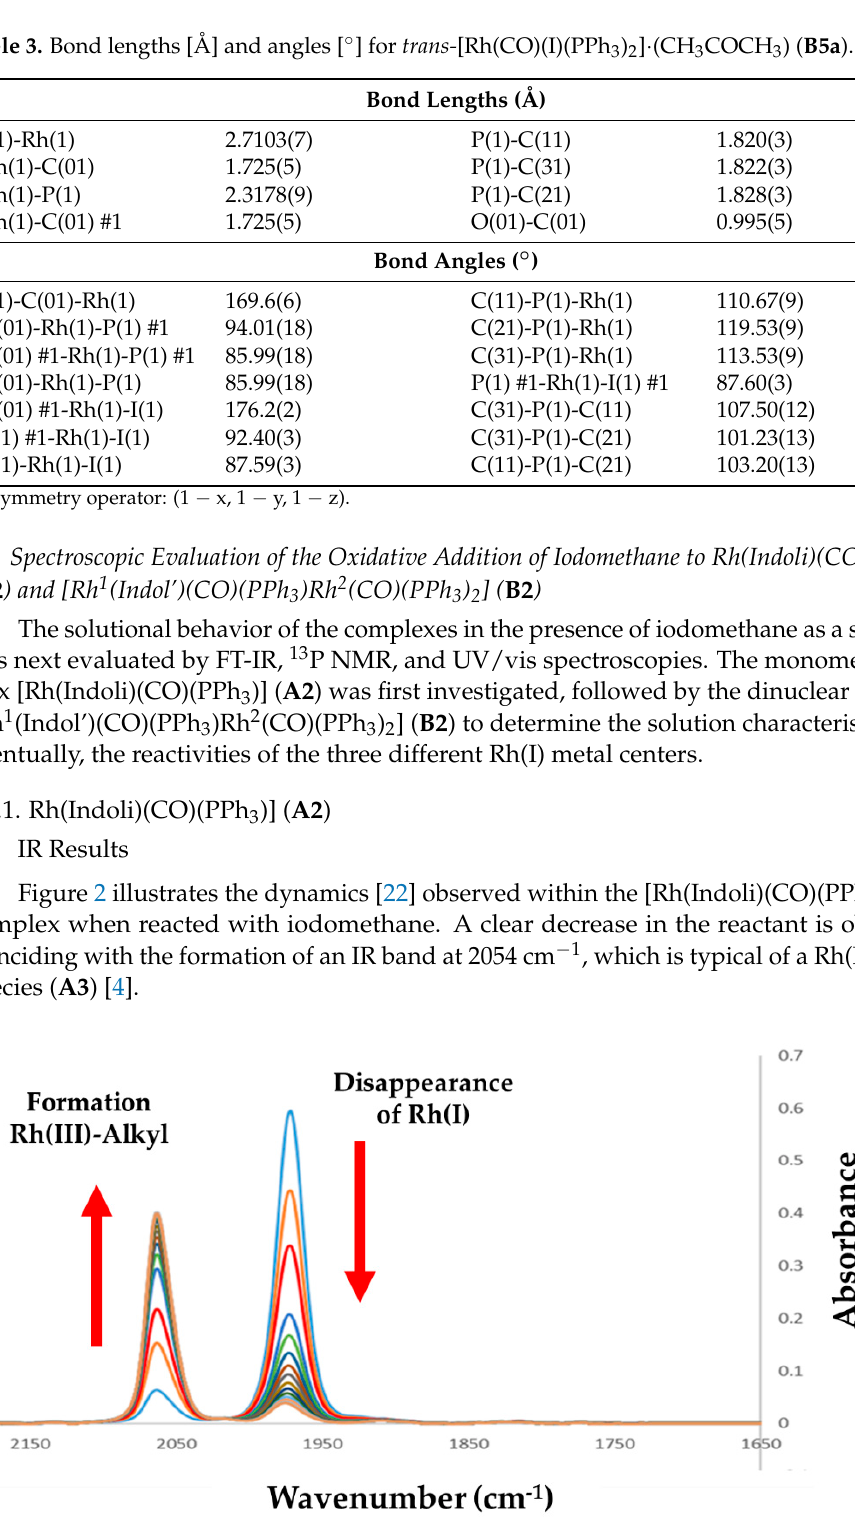
Figure 2. Successive IR spectra illustrating the oxidative addition of iodomethane to [Rh(Indoli)(CO)(PPh 3 )] ( A2 ) ( ν (CO) =1976 cm –1 ) and the formation of the Rh III -alkyl A3 ( ν (CO) =2054 cm –1 ); [Rh] = 0.01 M, [MeI] = 1.0 M, Δ t = 120 s; Total time = 30 min.